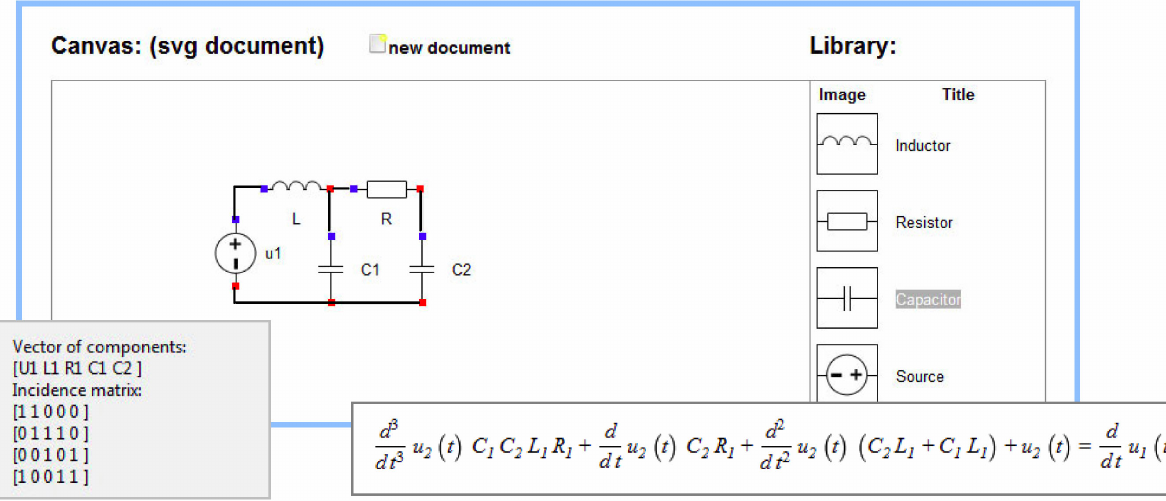
Figure 3. Web application for modeling of RLC circuits